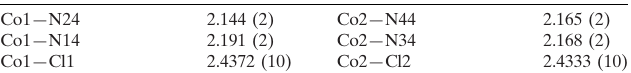
Selected bond lengths (A˚ ).